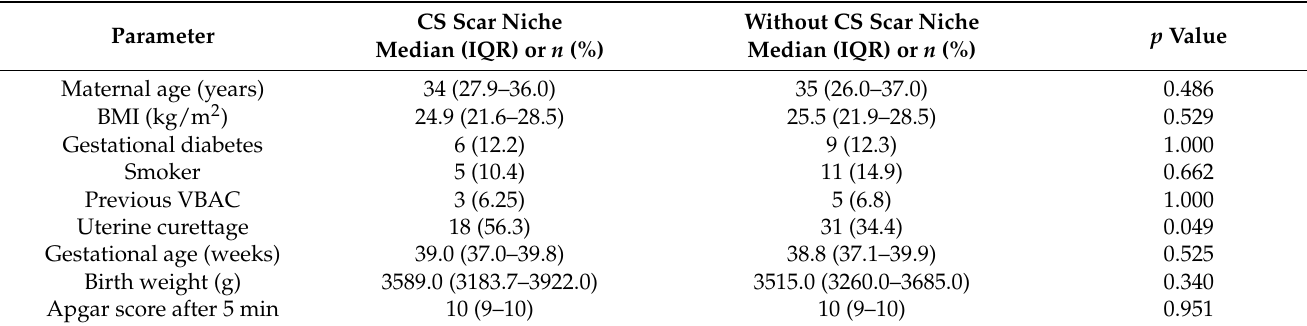
Table 2. Demographic and obstetric characteristics of the eligible